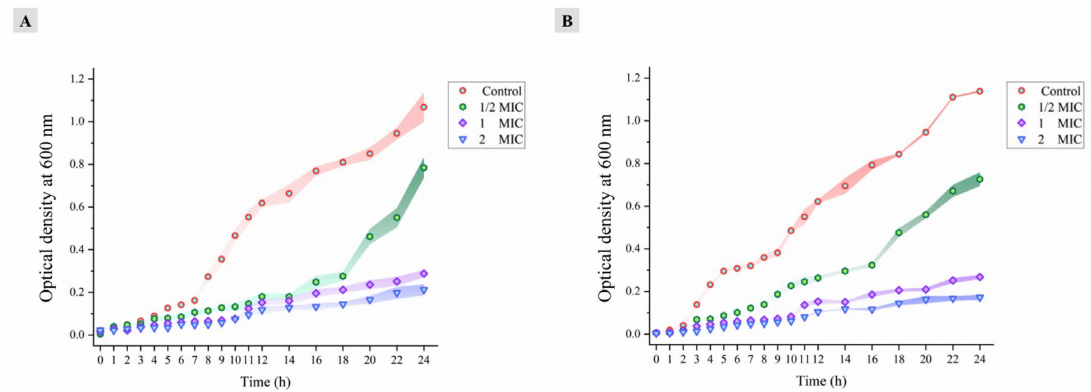
Figure 2. ( A ) MDR Staphylococcus aureus SA-596. ( B ) MDR Pseudomonas aeruginosa PA-69. The values are expressed as the mean ± standard deviation (n =